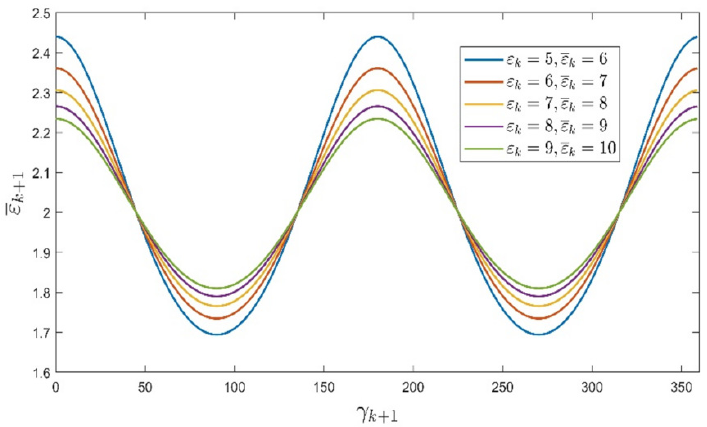
Figure 5. Multi-AUV cooperative positioning error propagation characteristics.